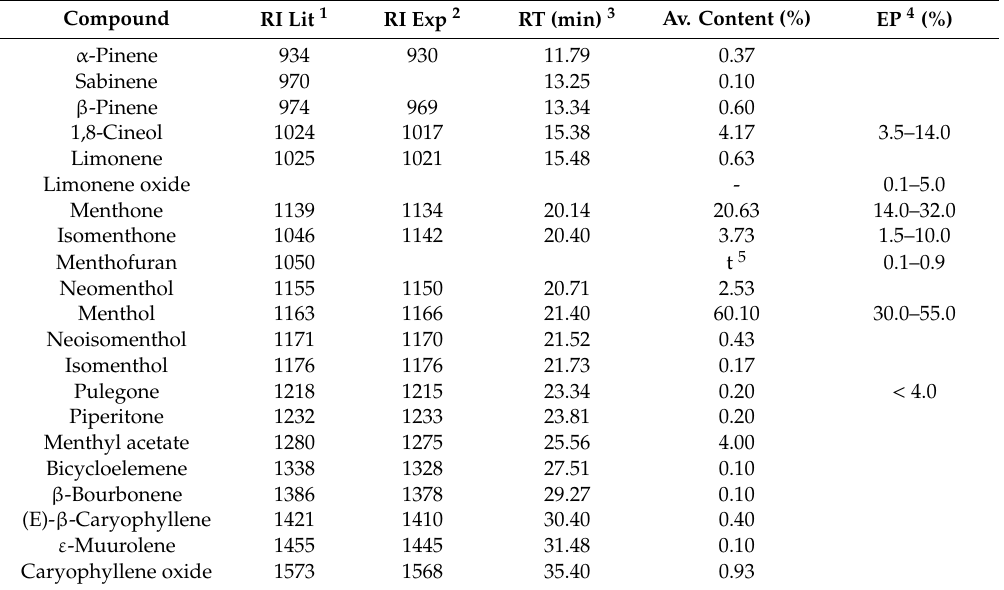
Table 1. Chemical composition of peppermint oil encapsulated in the maltodextrin microcapsules.